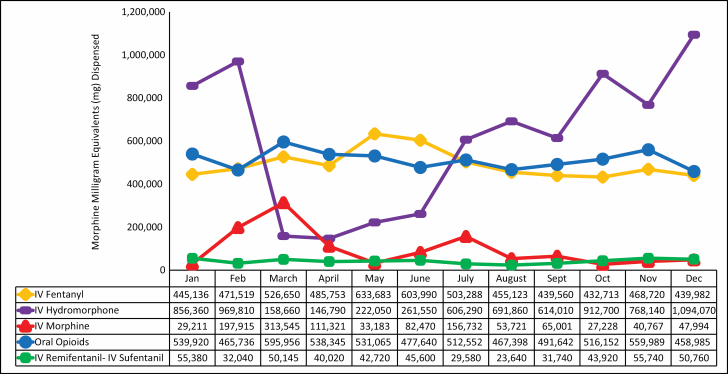
Opioids dispensed to hospitalized inpatients in 2018